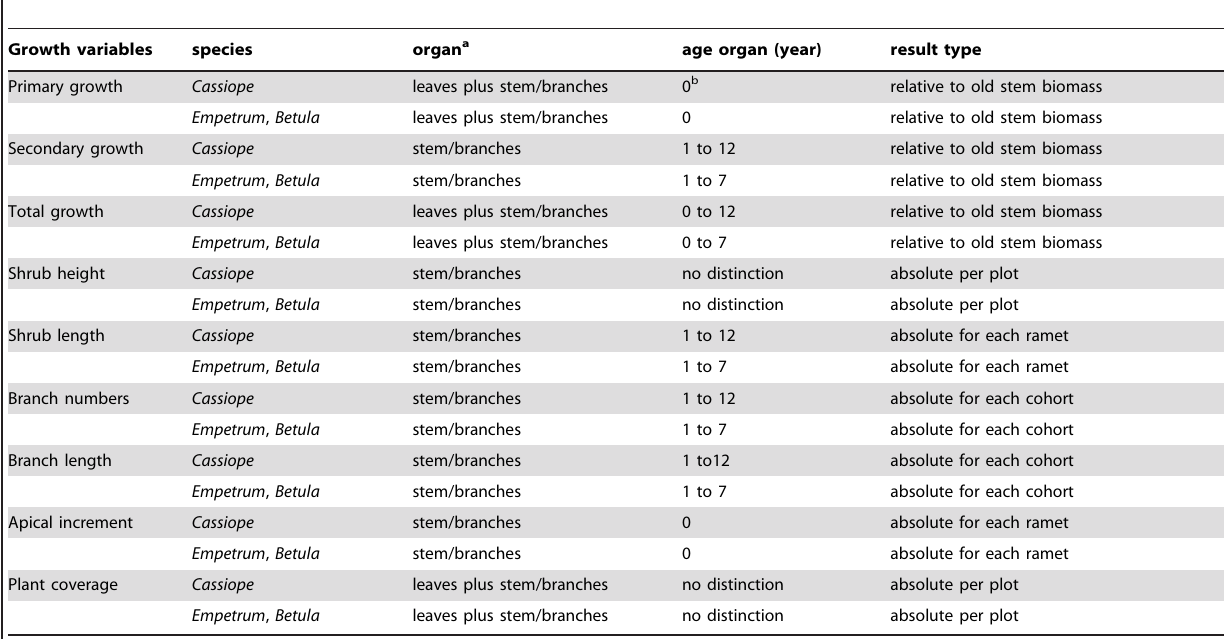
Table 4. Summary of the shrub growth variables measured in this study, the plant organ and organ age they refer to and the way the results are